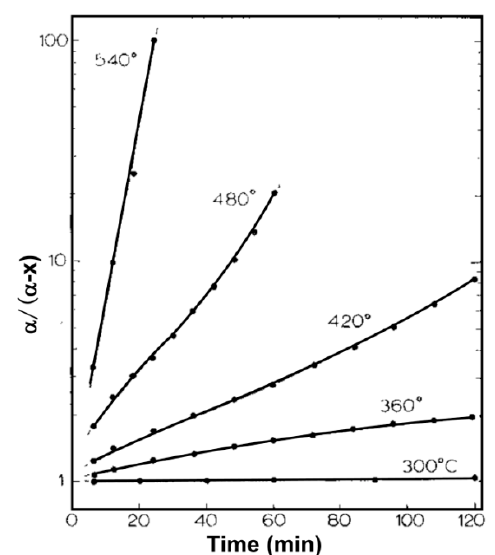
Figure 10. First order kinetic plot of the reduction data for lead oxides [24]. The required reduction time to reach the same content of Pb was shortened greatly when the temperature exceeded 690 K, where α is the fraction of reduction.